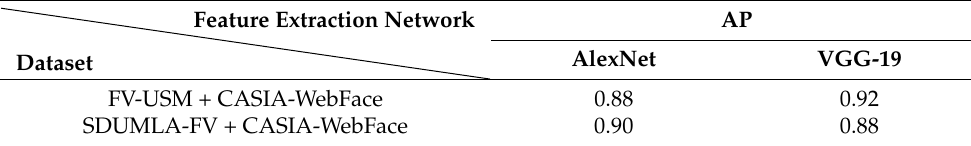
Table 7. Summary of AP values of different datasets under different feature extraction networks.